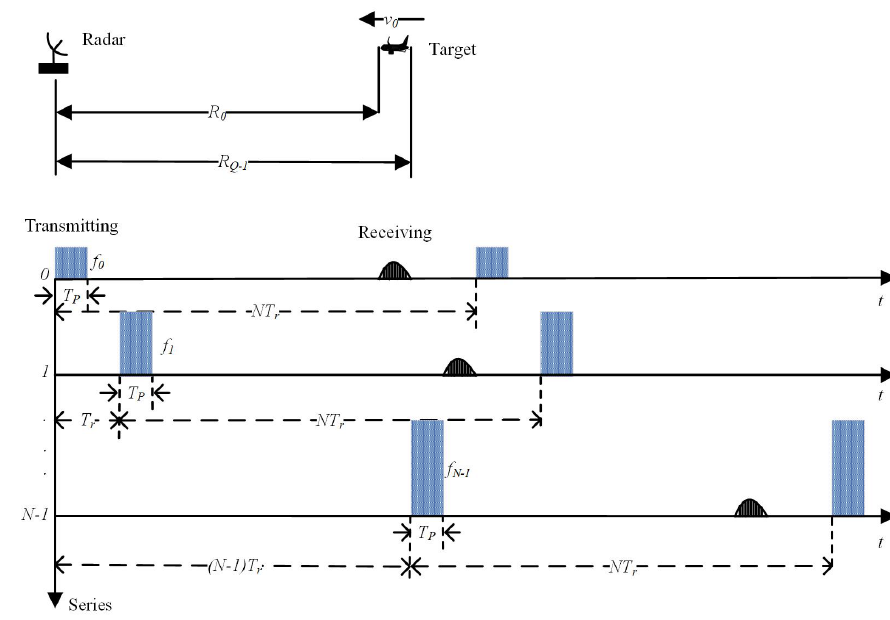
Figure 1. Scenario of a moving target in normal SF